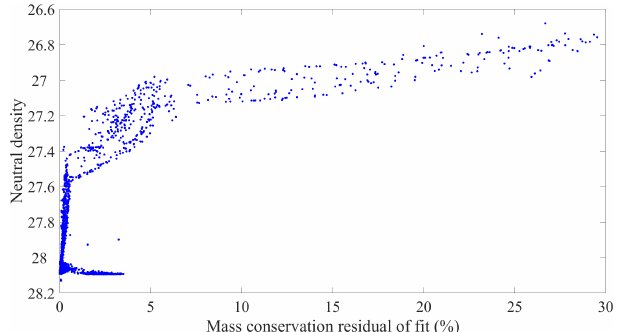
Figure 2. An example of a mass conservation residual in OMP anal- ysis for the A03 section. This figure indicates that in density layers outside of the water masses included in the analysis, we find a high residual; i.e. the OMP analysis should only be used for a certain density